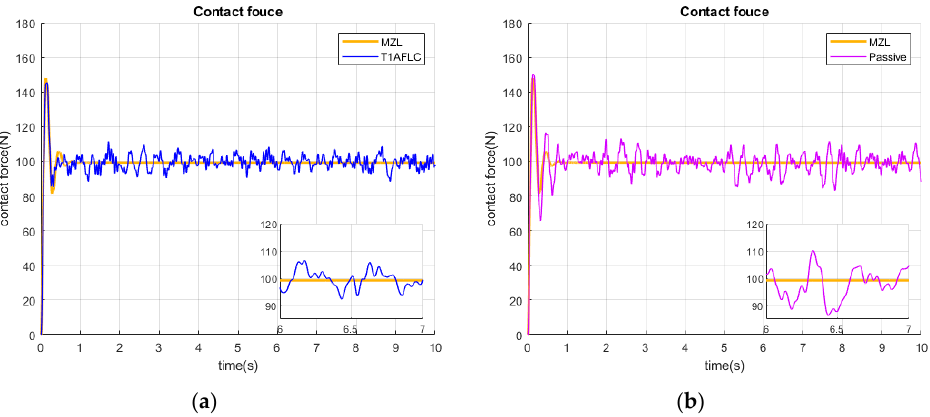
Figure 6. The contact force regulation performance. ( a ) The contact force for T1AFLC and the proposed IT2AFLC. ( b ) The contact force for passive control and the proposed IT2AFLC .